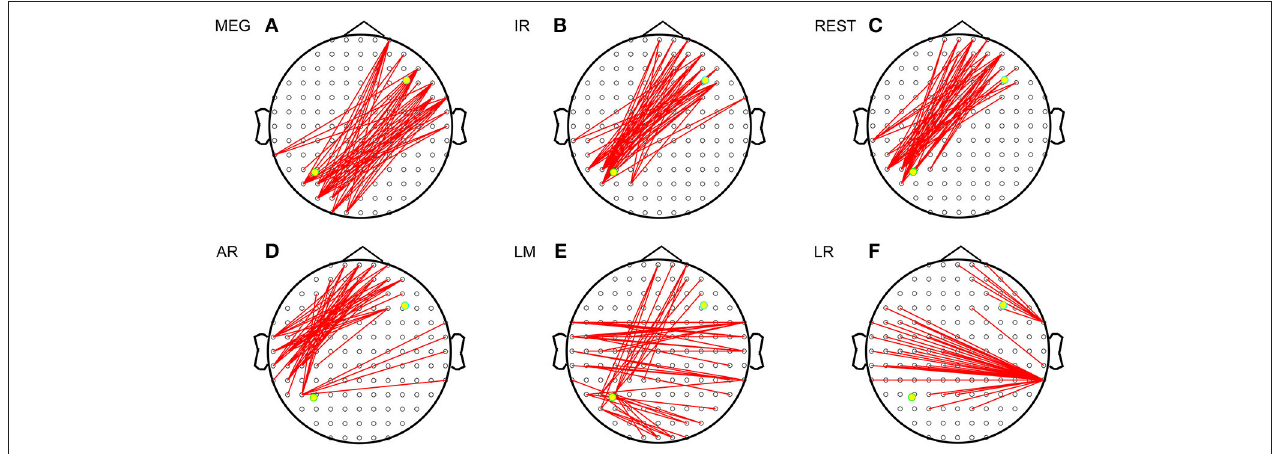
FIGURE 3 | Imaginary coherence-based sFCTs derived using different methods. Network sparsity was set to 50. The red segments represent the connections between two electrodes and the two yellow dots represent the simulated sources. (A) sFCT of MEG. (B) sFCT of IR. (C) sFCT of REST. (D) sFCT of AR. (E) sFCT of LM. (F) sFCT of